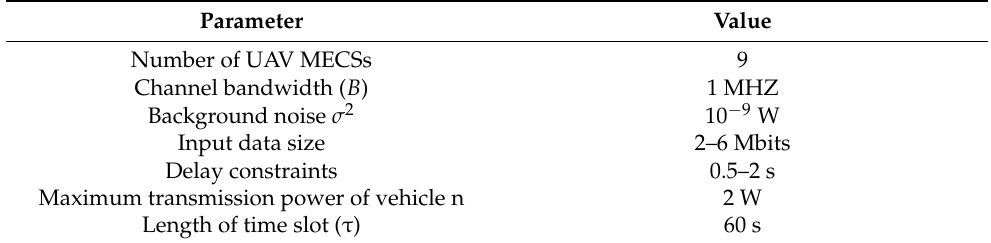
Table 1. Experiment parameter